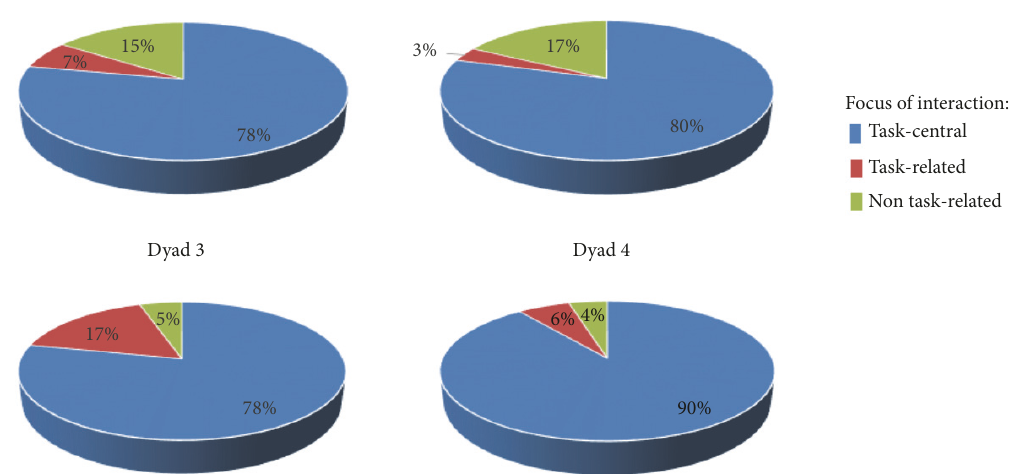
Figure 1: The distribution in time of the three different interactional foci in the four